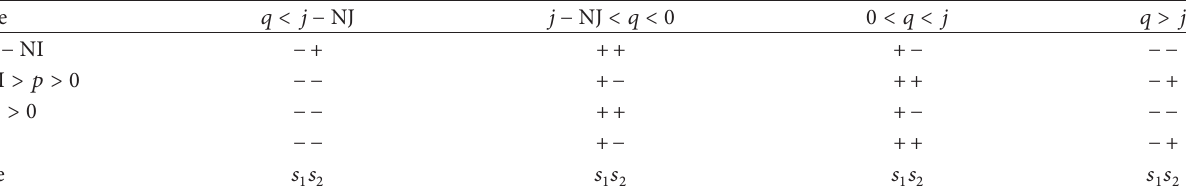
Table 1: Sign control functions.